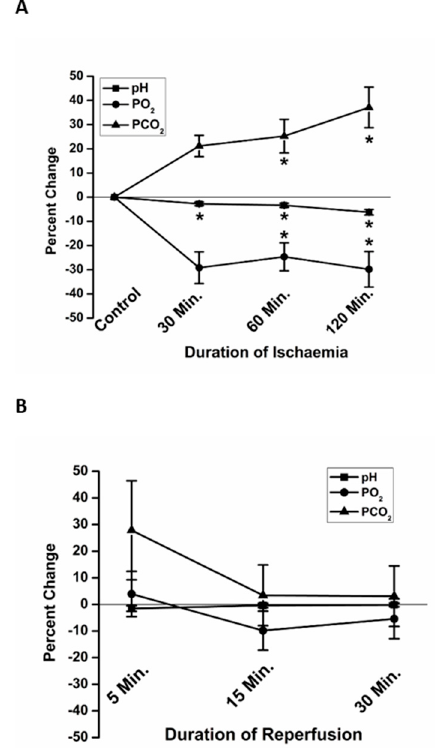
Figure 3. The in vitro changes in partial pressures of oxygen (PO 2 ) and carbon dioxide (PCO 2 ), and pH, mimicked changes known to occur in vivo during ischemia and reperfusion. At 60 and 120 min, significant acidosis (squares), elevation in PCO 2 (triangles) and decline in PO 2 (circles) were observed ( A ). All values returned to basal levels following reperfusion ( B ). Data are presented as percent change relative to Time 0, immediately prior to the beginning of ischemia. * p < 0.05 relative to Time 0.